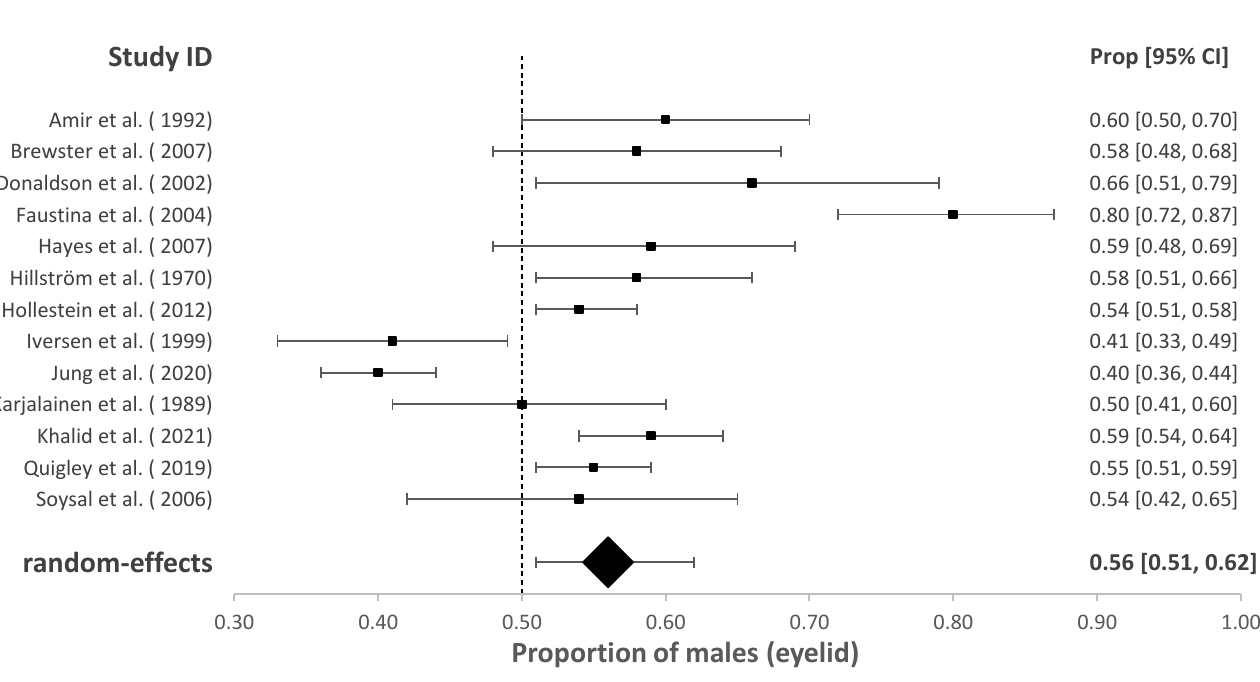
Figure 5. Proportion of males with cSCC of the eyelid.[17,21,26,29 – 32,38,39,45,63,66]